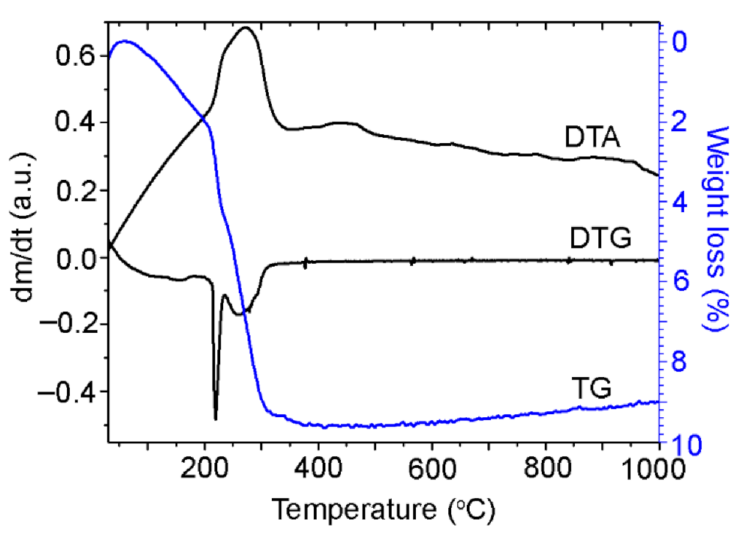
Figure 15. Differential thermal analysis (DTA), differential thermogravimetric analysis (DTG), and thermogravimetric (TG) curves for FA/CeO 2 . Table 8. Pyrolysis yields for TGA pyrolysis of FA/CeO 2 (0.6 mmol/g).